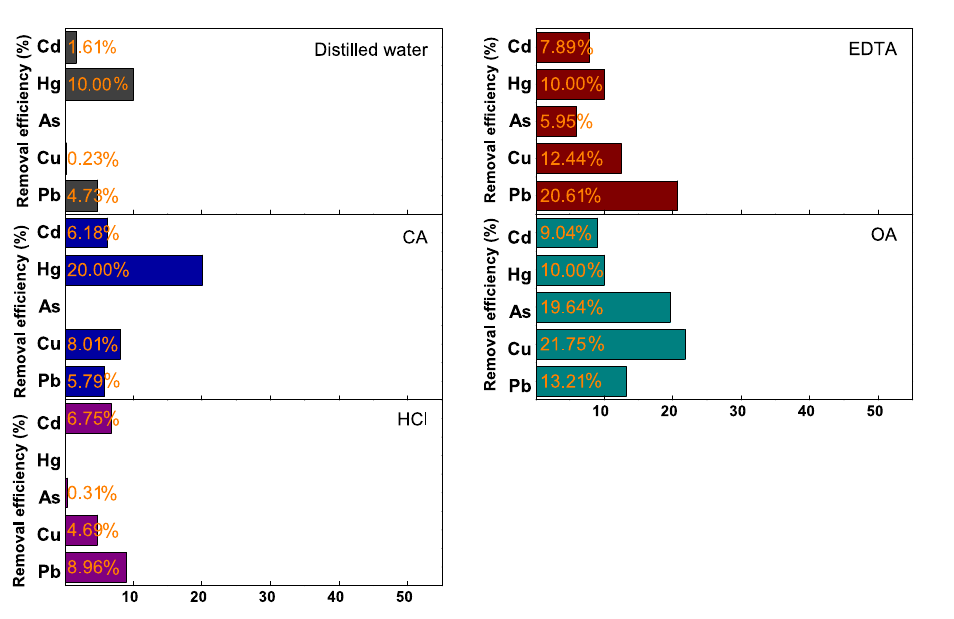
Figure 2. Comparison of the heavy metal removal efficiencies of various